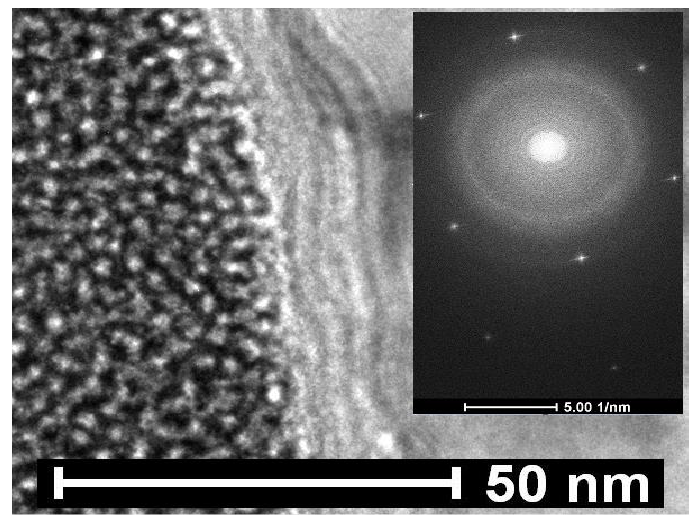
Figure 2. TEM Image of Si NW confined in the nanolayer on amorphous film, where the inset shows the electronic di ff raction pattern of the Si NW structure.